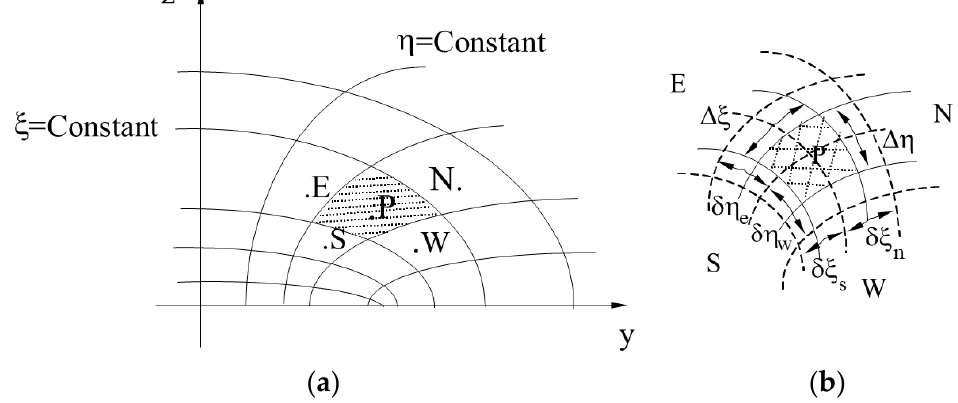
Figure 2. Continuous surface subdivided into nodal points. ( a ) Identification of the control volume and ( b ) geometric parameters of the control volume in the oblate spheroidal coordinates system.